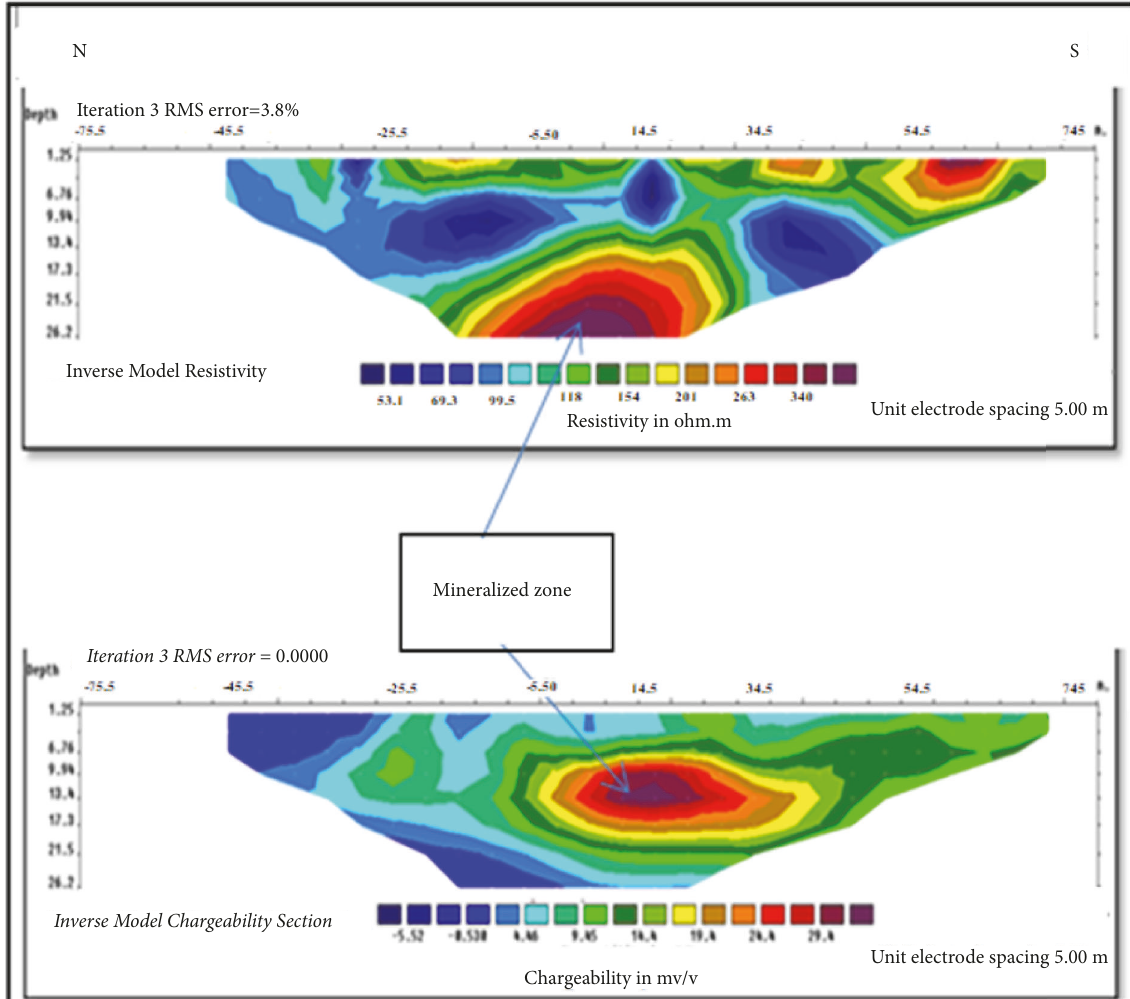
Figure 13: Inverse model resistivity and chargeability sections (Tabesbaste 3; direction: